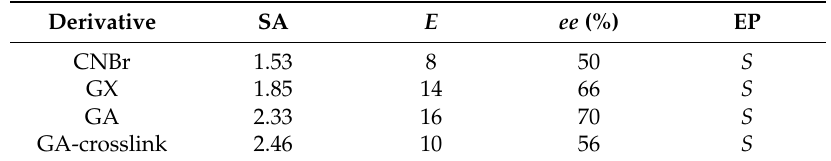
Table 6. Activity and enantioselectivity of lipase derivatives in the hydrolysis of racemic-Methyl mandelate. Derivative